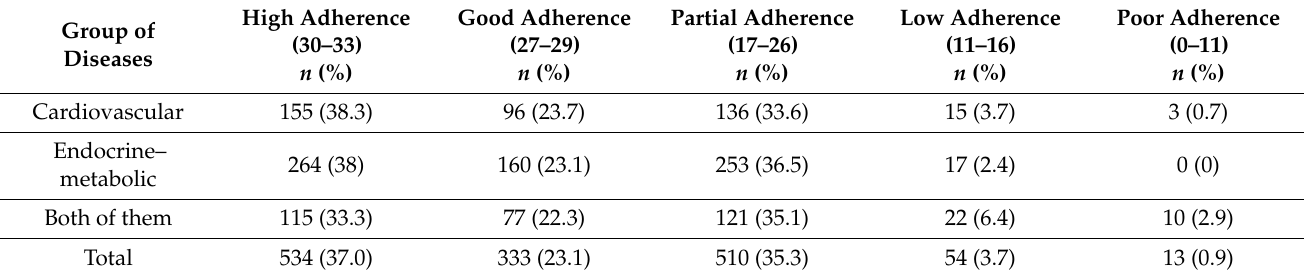
Table 2. Adherence in each disease group attended to the GMAS.